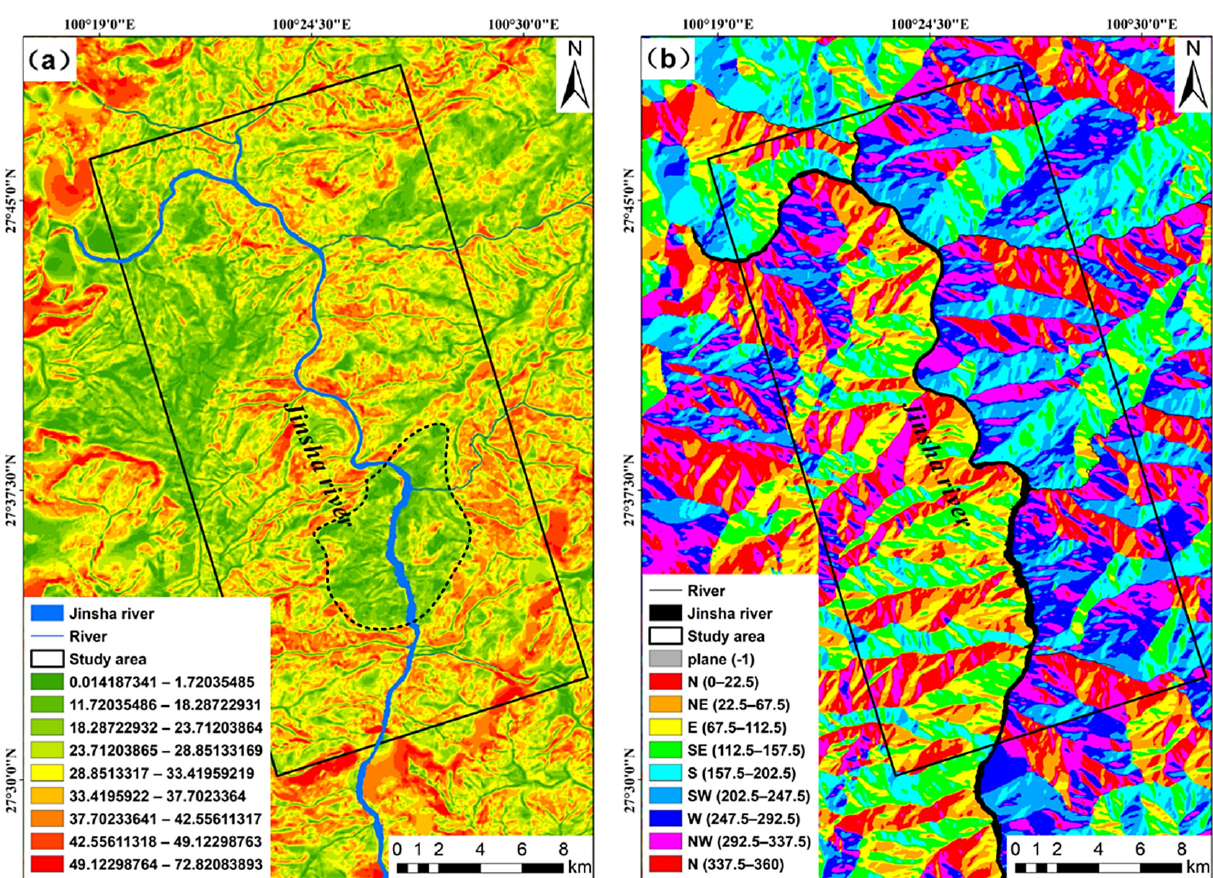
Figure 2. Slope and aspect maps of the study area: ( a ) slope and ( b ) aspect.